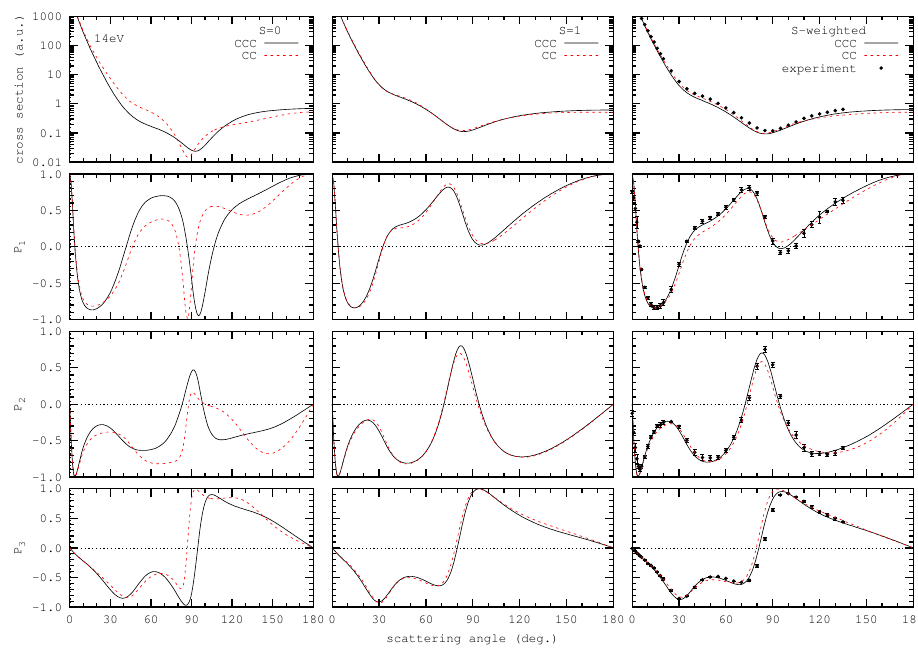
Figure 2. Same as for Figure 1, except for 14 eV.